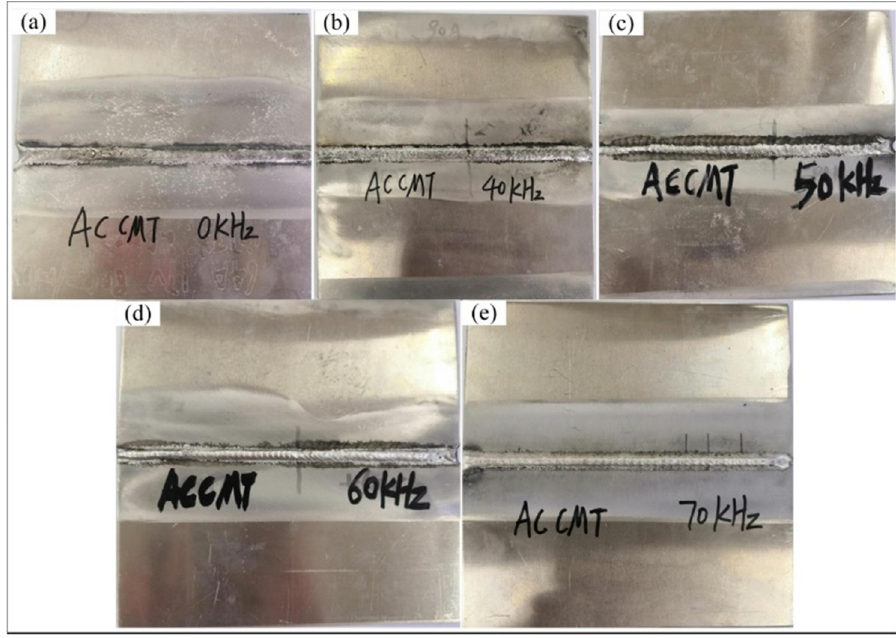
Figure 4: Welded plates made with different frequencies: ( a ) 0 kHz, ( b ) 40 kHz, ( c ) 50 kHz, ( d ) 60 kHz, and ( e ) 70